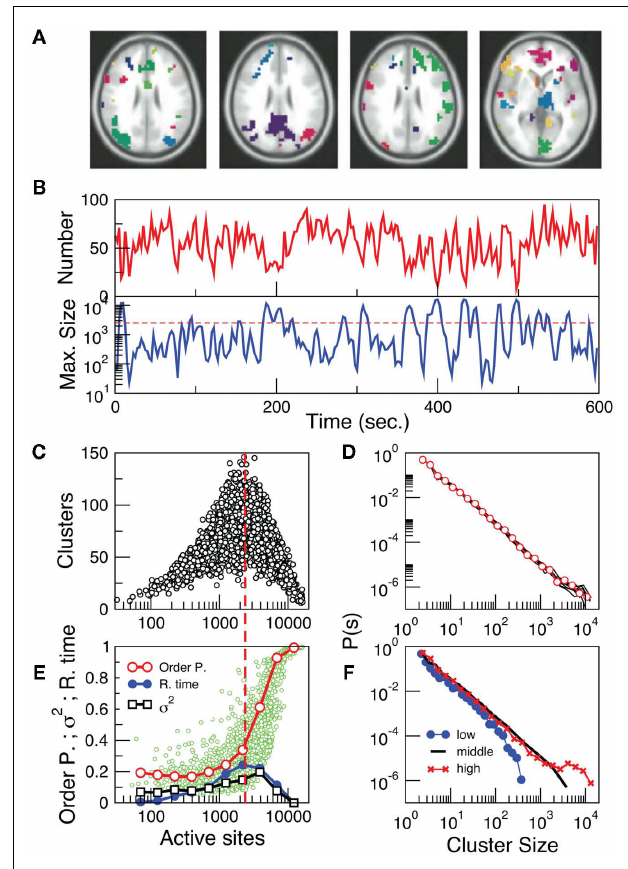
FIGURE 3 |The level of brain activity continuously fluctuates above and below a phase transition. (A) Examples of co-activated clusters of neighbor voxels (clusters are 3D structures, thus seemingly disconnected clusters may have the same color in a 2D slice). (B) Example of the temporal evolution of the number of clusters and its maximum size (in units of voxels) in one individual. (C) Instantaneous relation between the number of clusters vs. the number of active sites (i.e., voxels above the threshold) showing a positive/negative correlation depending whether activity is below/above a critical value [ ∼ 2500 voxels, indicated by the dashed line here and in (B) ]. (D) The cluster size distribution follows a power law spanning four orders of magnitude. Individual statistics for each of the ten subjects are plotted with lines and the average with symbols. (E) The order parameter, defined here as the (normalized) size of the largest cluster is plotted as a function of the number of active sites (isolated data points denoted by dots, averages plotted with circles joined by lines).The calculation of the residence time density distribution (R. time, filled circles) indicates that the brain spends relatively more time near the transition point (which corresponds to about 0.4 of the largest giant cluster observed). Notice that the peak of the R.Time in this panel coincides with the peak of the number of clusters in (C) . Note also that the variance of the order parameter (squares) increases as expected for a phase transition. (F) The computation of the cluster size distribution calculated for three ranges of activity (low: 0–800; middle: 800–5000; and high > 5000) reveals the same scale invariance plotted in (D) for relatively small clusters, but shows changes in the cut-off for large